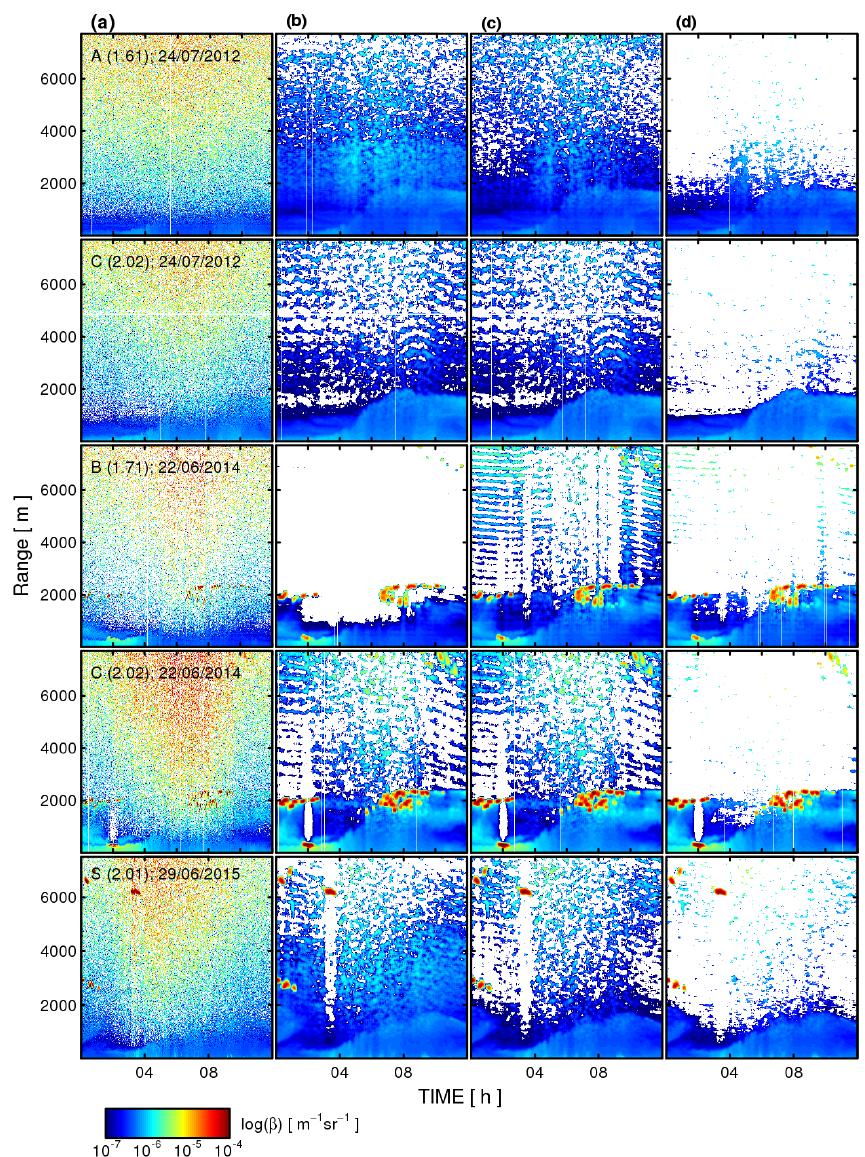
Figure 10. CL31 observations on 24 July 2012 (rows 1 and 2), 22 June 2014 (rows 3 and 4), and 29 June 2016 (row 5) from four sensors with firmware version in brackets: A (1.61), B (1.71), C (2.02), and S (2.01); see Table 2. (a) Range-corrected attenuated backscatter β · r 2 at 15s resolution (rows 1–4) and 30s (row 5) as reported; (b) as in (a) with running average ( ∼ 25min, ∼ 100m) applied (Eq. 12); (c) as in (b) but including correction of instrument-related background signal and potential cosmetic shift (see Sect. 3.1); and (d) as in (c) but filtered for SNR> T 2 , with T 2 = 0 . 18 (see discussion on Fig. 9). Note: for simplicity the absolute calibration constant is here assumed to be c absolute = 1 (Sect. 4.1) for all sensors. This is not necessarily expected to be a correct assumption in reality but applied to show the impact of corrections on the final product, i.e. the attenuated